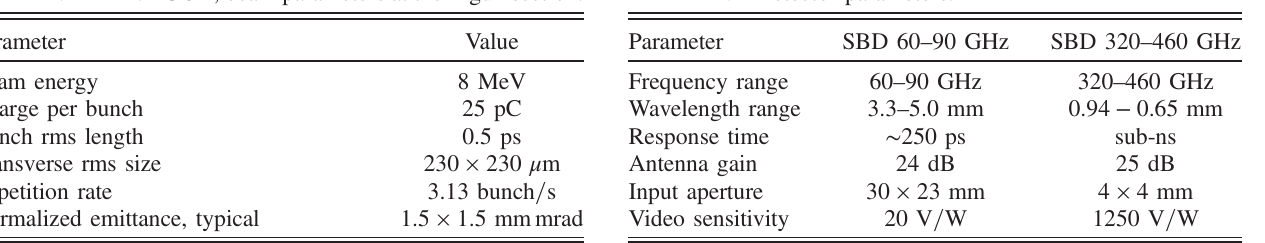
TABLE I. KEK: LUCX, beam parameters at the rf gun section. TABLE II. Detector parameters.